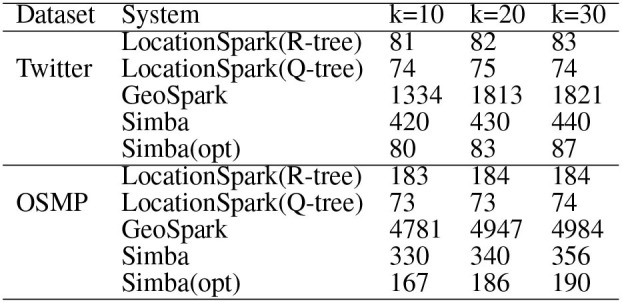
kNN select (in ms).